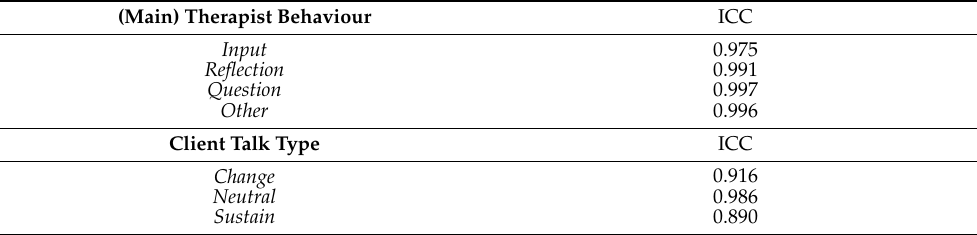
Table 10. Inter-annotator agreement as intraclass correlation. (Main) Therapist